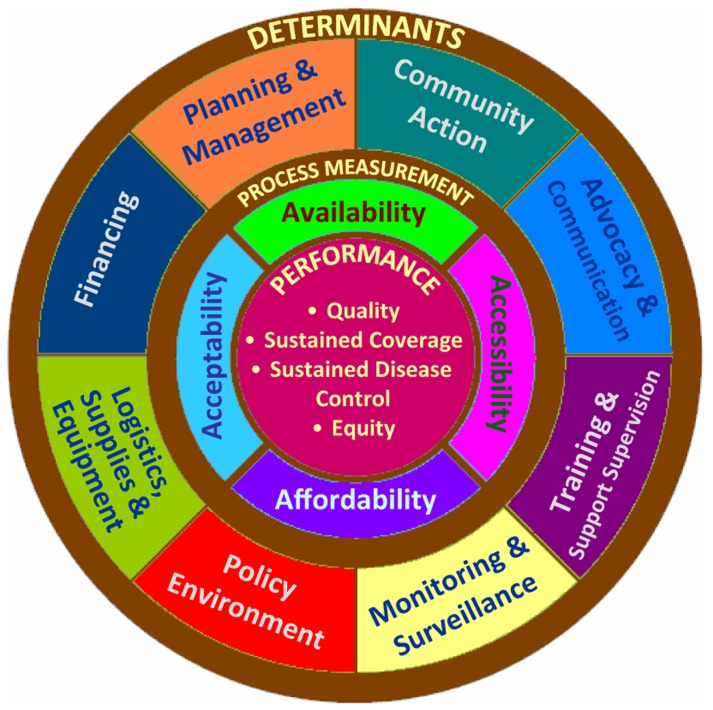
Conceptual Framework: Immunization Sub-SystemSource: Adapted from reference 15.